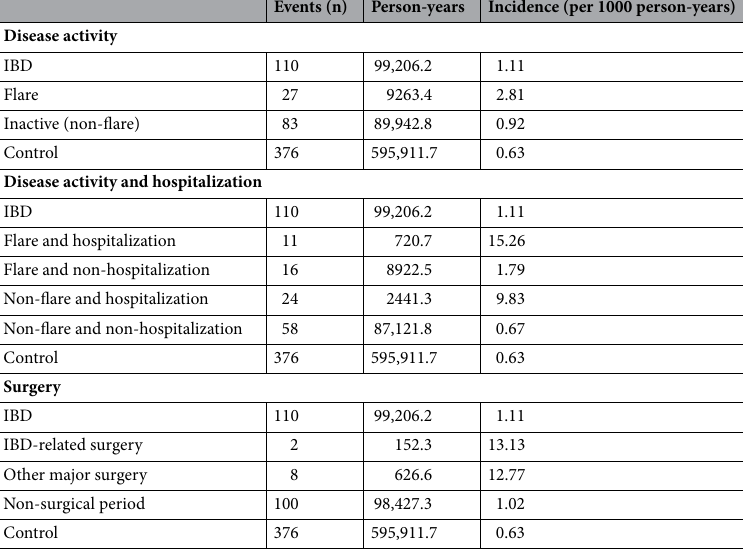
Table 4. Incidence of venous thromboembolism by disease activity, hospitalization, and surgery.